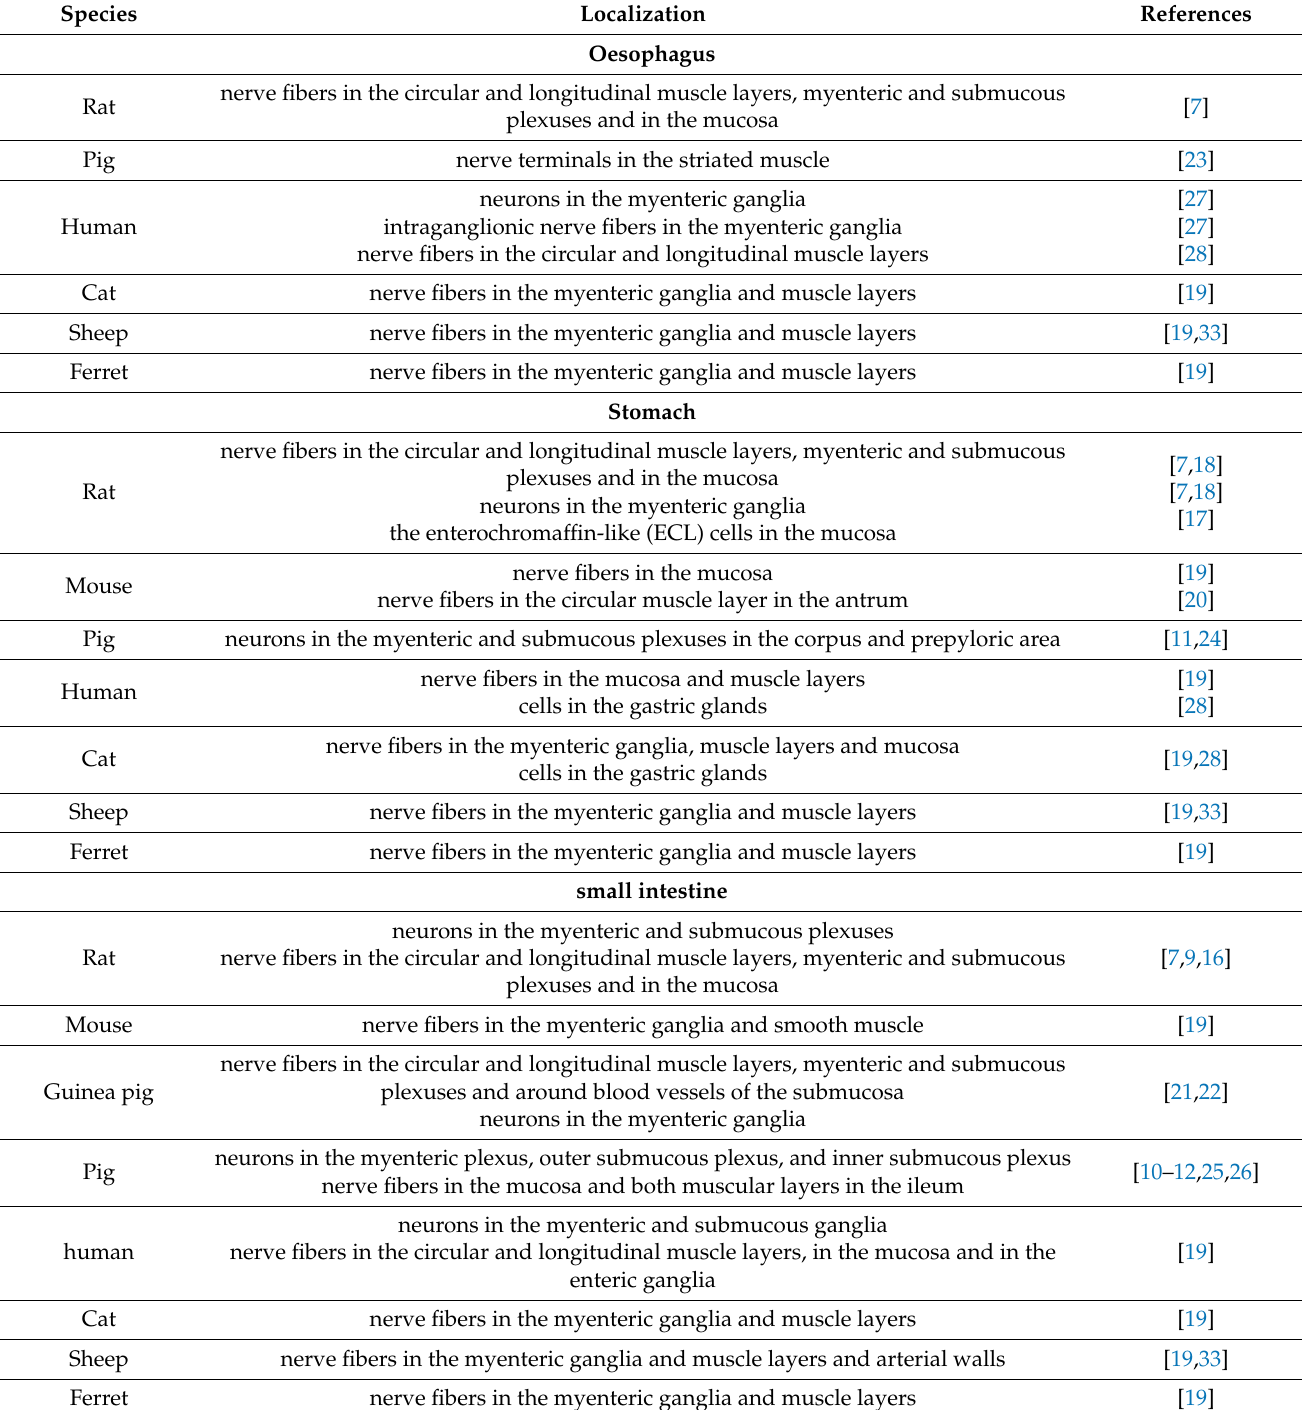
Table 1. Distribution of PACAP in the GI tract of various mammals’